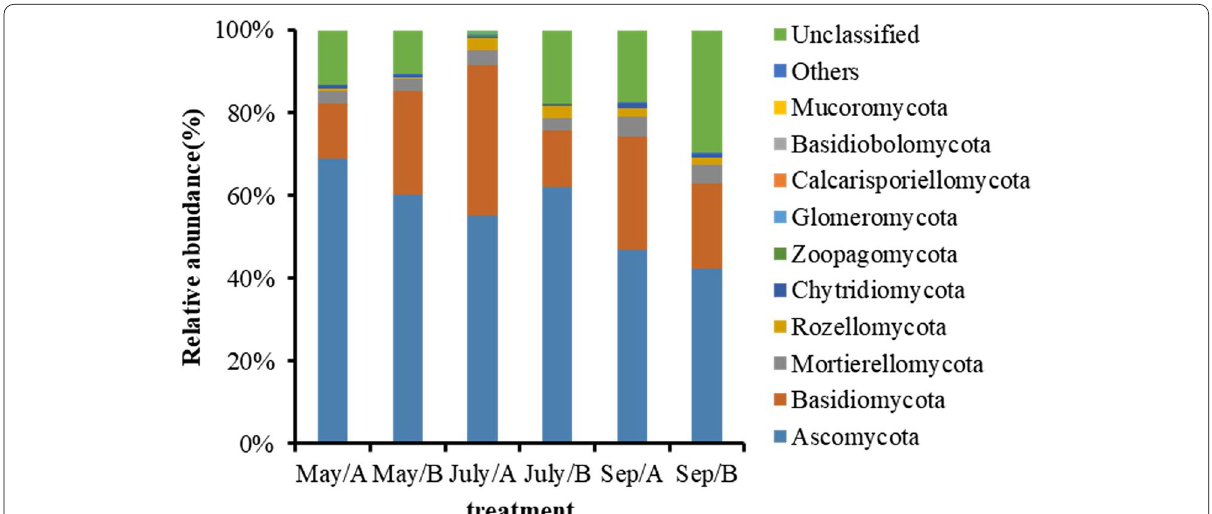
Fig. 4 Relative abundance of main fungal phyla communities in soil in intercropping and monoculture of a banana orchard. May/A Intercropping treatment in May. May/B Monoculture treatment in May. July/A Intercropping treatment in July. July/B = = in July. Sep/A Intercropping treatment in September. Sep/B Monoculture treatment in = =